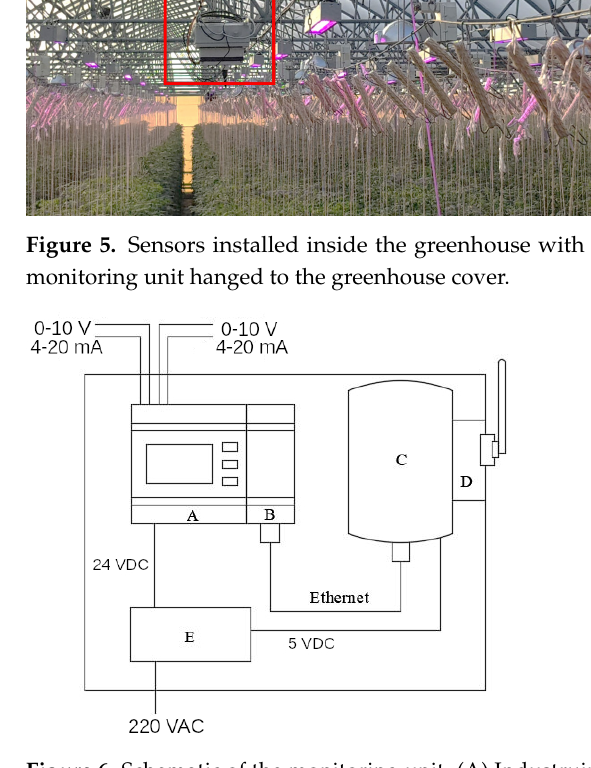
Figure 6. Schematic of the monitoring unit. (A) Industruino IND I/O 1286; (B) Industruino Ethernet module; (C) Raspberry PI Model 3; (D) GPRS unit; (E) power supply. The two 4–20 mA connections acquire the data from the indoor and outdoor pyranometers; the two 0–10 V connections acquire the data from the indoor and outdoor Photosynthetic Active Radiation